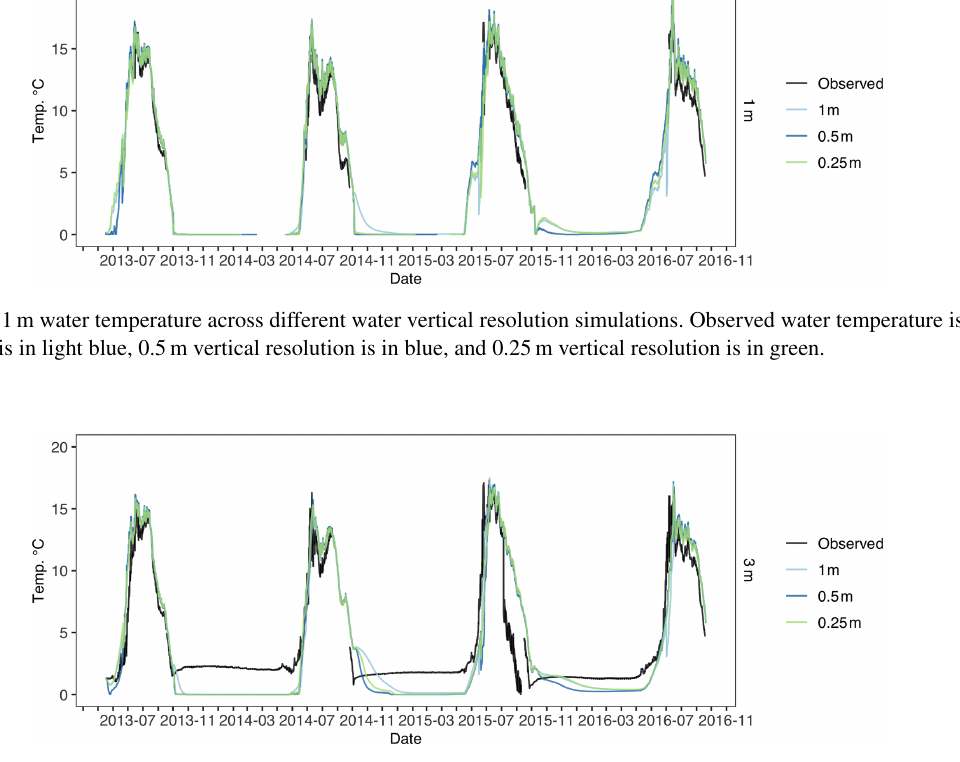
Geosci. Model Dev., 15, 7421–7448,